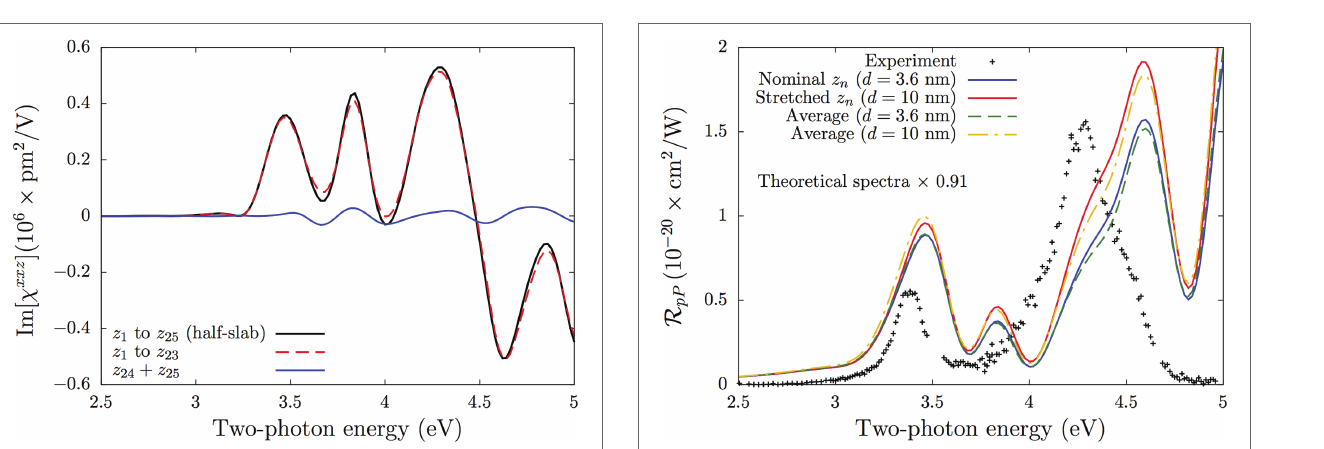
FIGURE 4 | R pP for z n as given by the slab (Nominal, red line), with z n stretched by 2.7 (Stretched, blue line), and using the half-slab value of (cid:31) hsabc for d = 3.6 (Average, dashed green line) and d = 10nm (Average, dashed yellow line), see text for details . The experimental data are from the study by Mejía et al. (2002). We use θ = 65 (cid:14) , ϕ = 30 (cid:14) , and a broadening of σ = 0.075eV. Both the Nominal and Stretched results are ab initio ,